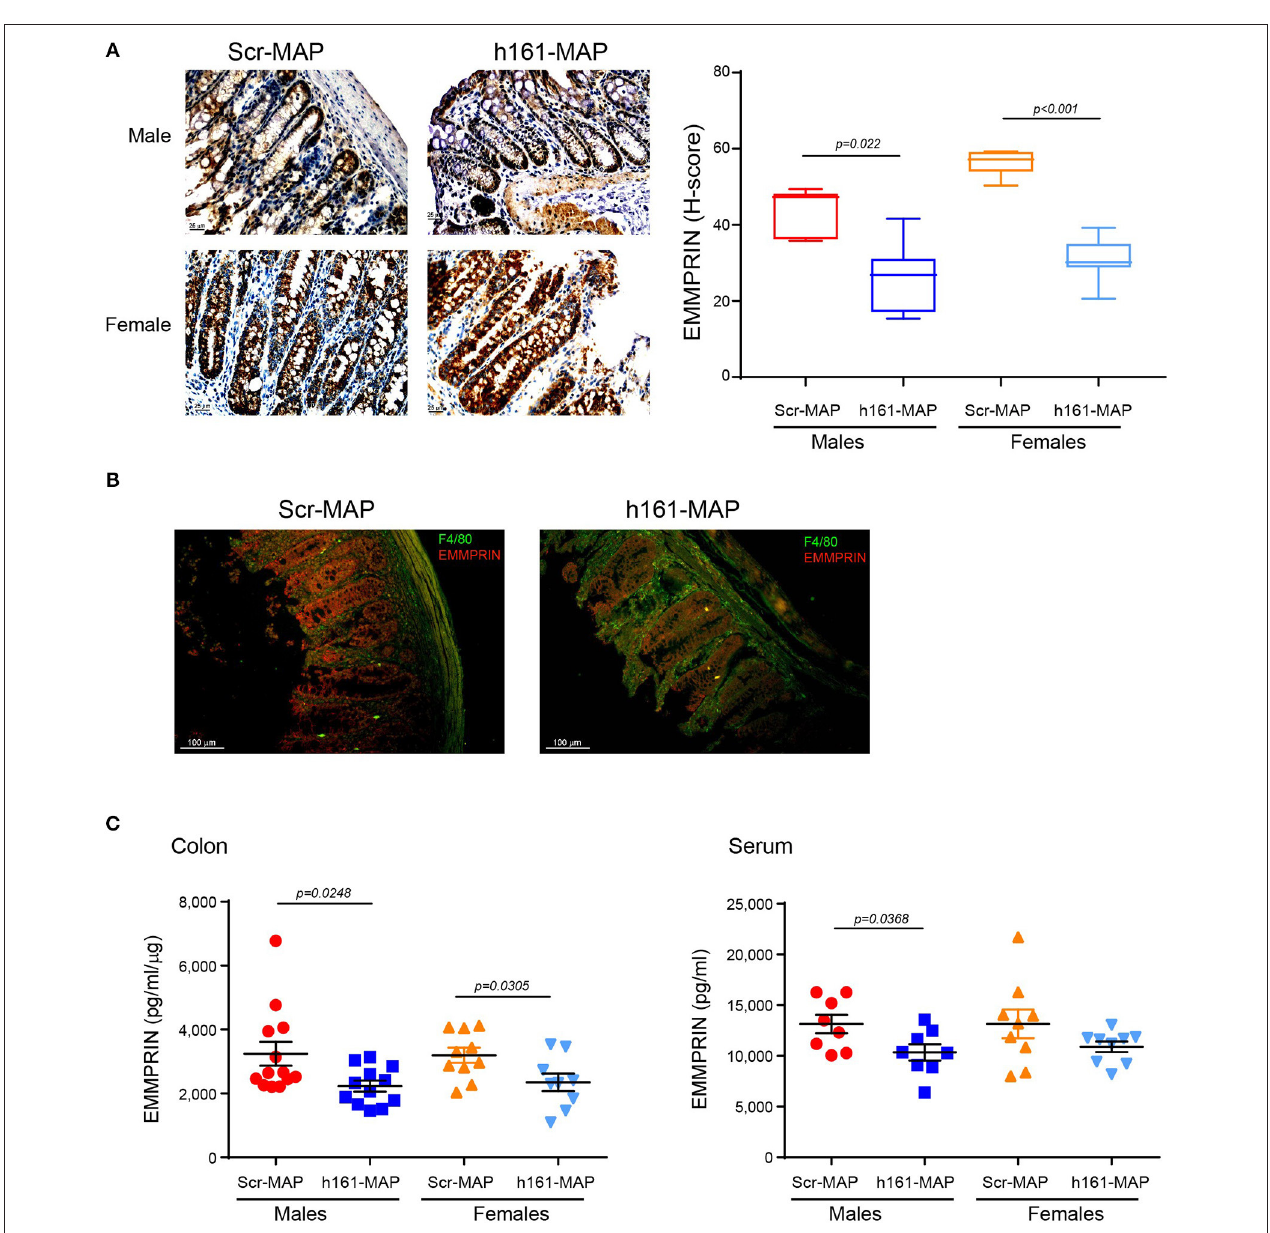
FIGURE 3 | 161-MAP active vaccination reduces EMMPRIN expression in the colon. (A) Representative images of colon sections stained for EMMPRIN and their quantification using the H-score ( n = 5 per group). Scale bar is 25 µ m (B) Representative image of fluorescently labeled EMMPRIN (red) and macrophages (green). Scale bar is 100 µ m. (C) Determination of EMMPRIN concentrations in colon lysates ( n = 9–10 per group), and in serum samples ( n = 8–9 per group) by ELISA.